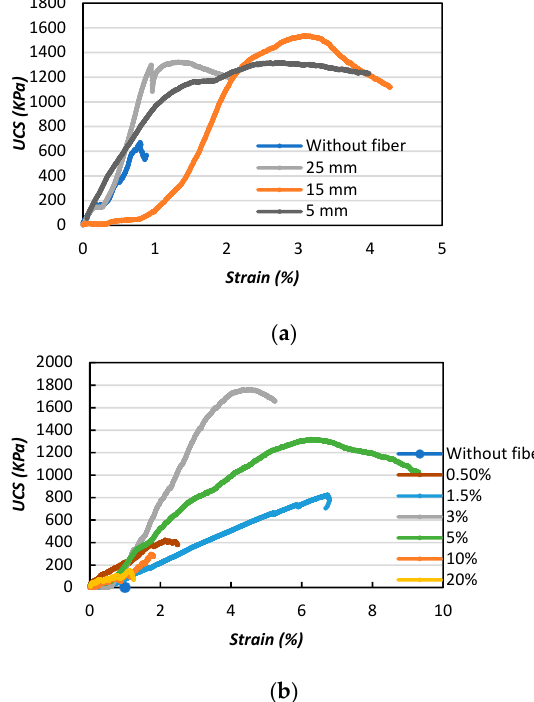
Figure 10. Effects of fiber on the unconfined compressive strength (UCS) of the biocement sand with Figure 10. E ff ects of fiber on the unconfined compressive strength (UCS) of the biocemented sand with the addition of jute fibers: ( a ) fiber length; ( b ) fiber content. the addition of jute fibers: ( a ) fiber length; ( b ) fiber content.